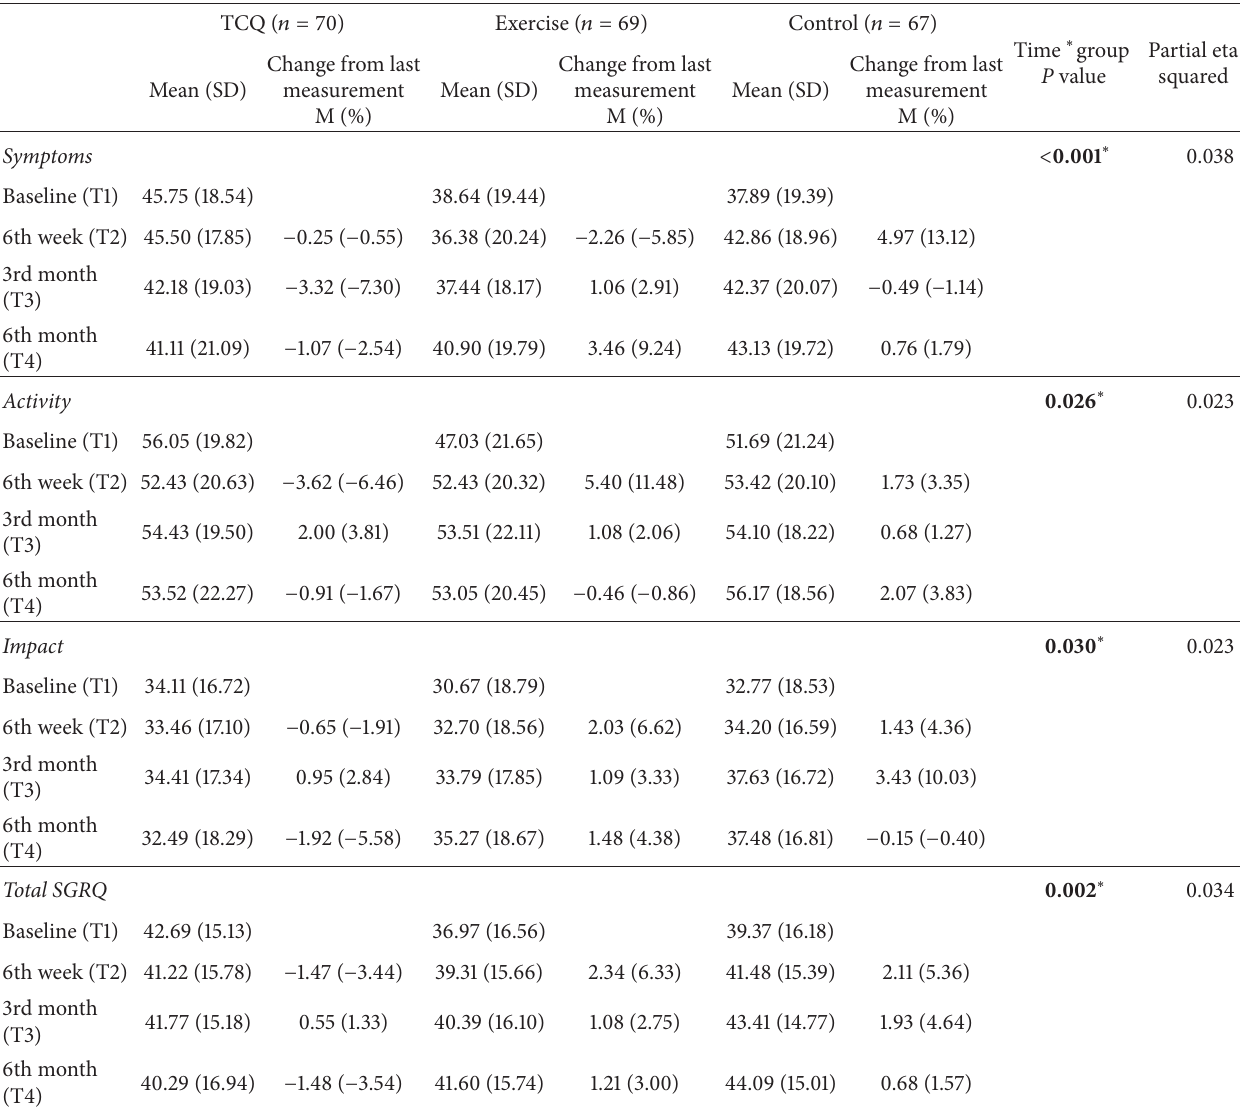
Table 2: Comparison of SGRQ at baseline, 6th week, 3rd month, and 6th